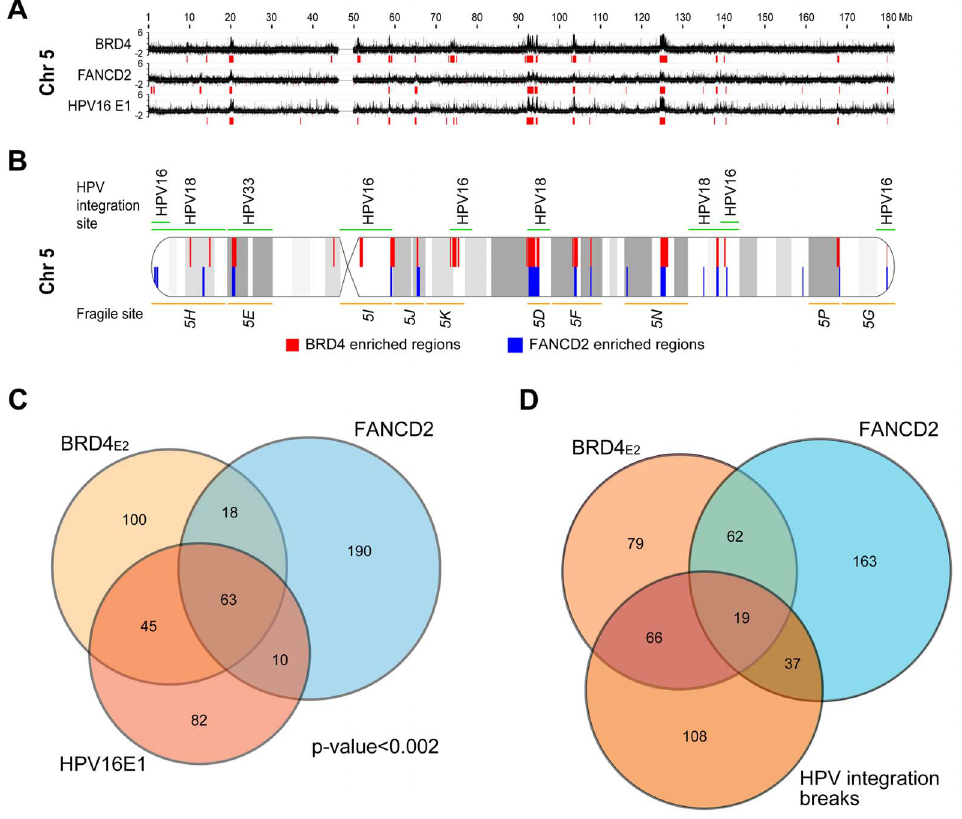
Figure 7. HPV16 E1/E2 binding sites are closely associated with PEB-BLOCs and common fragile sites. A. HPV16 E1 and E2 were transiently expressed in C-33 cells. ChIP-chip was performed using an anti-EE (E1) antibody. The Y-axis corresponds to a scaled log 2 -ratio of E1 signal to input signal. Previously obtained BRD4 (C-33-1E2 cells), and FANCD2 (aphidicolin-treated cells) binding profiles are aligned. Enriched regions were computationally defined and are shown in red under the signal map profile. Chromosome 5 is shown here and the entire data is shown in Figure S7. B. Diagram of chromosome 5 showing the overlap of BRD4 enriched regions (red), FANCD2 enriched regions (blue), common fragile sites (orange), and HPV integration sites (green) with cytogenetic bands in grey. C. A Venn diagram showing the overlap among the enriched BRD4, E1 and FANCD2 binding region regions, as defined by the permutation method. D. A Venn diagram showing the overlap among the enriched BRD4 and FANCD2 binding region regions and HPV integration breakpoints as defined by the permutation method. See Table 3 for statistics.